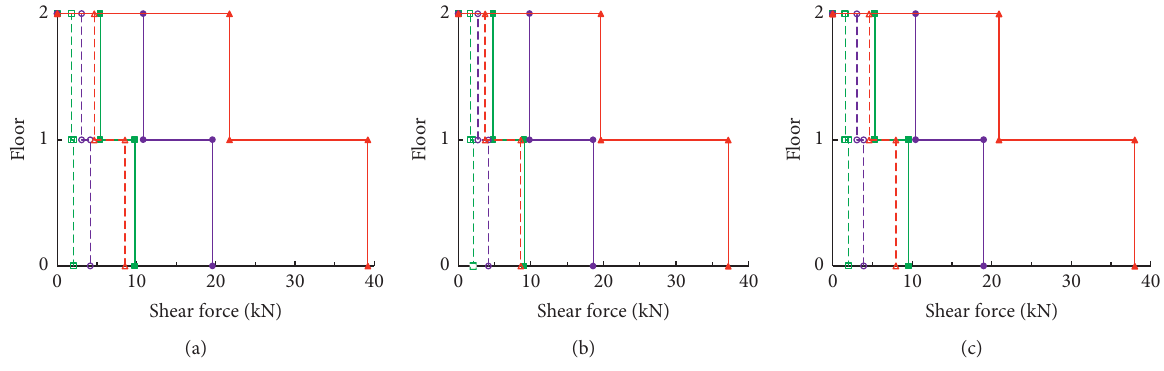
Figure 20: Comparison of floor shear force. (a) El Centro wave. (b) Kobe wave. (c) Taft